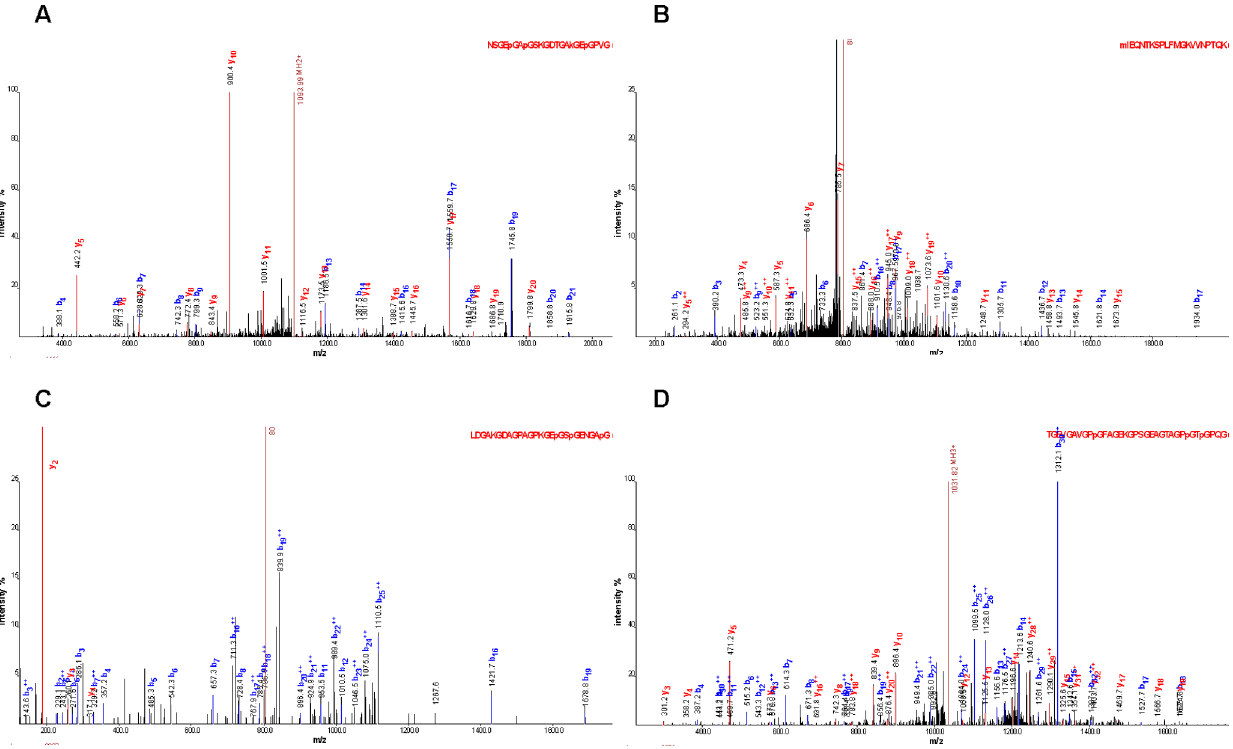
Figure 4. Annotated fragment spectra of new identified peptides. Four MS/MS spectra are shown exemplarily of the new identified DN biomarkers, like collagen alpha-1 (I) fragments ( A, C ), alpha-1-antitrypsin fragment ( B ), and a collagen alpha-2 (I) fragment ( D ). The corresponding sequence is displayed above each spectrum (p=hydroxylation of P; k=hydroxylation of K; m=oxidation of M). Identified b-ions are marked in blue and y-ions in red color.